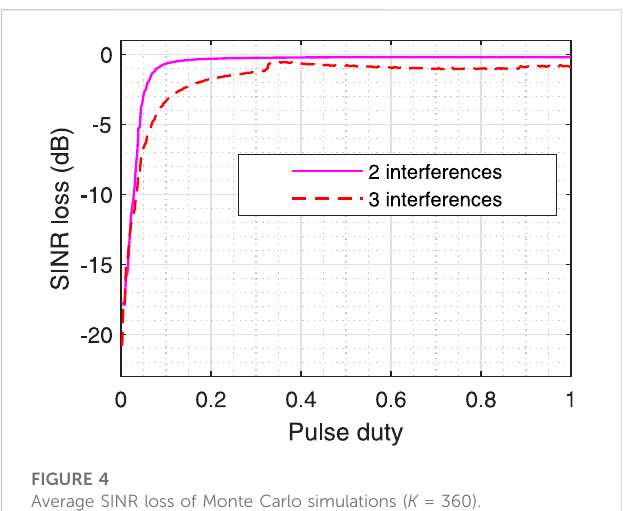
FIGURE 5 SINR loss of one-time simulation ( K =